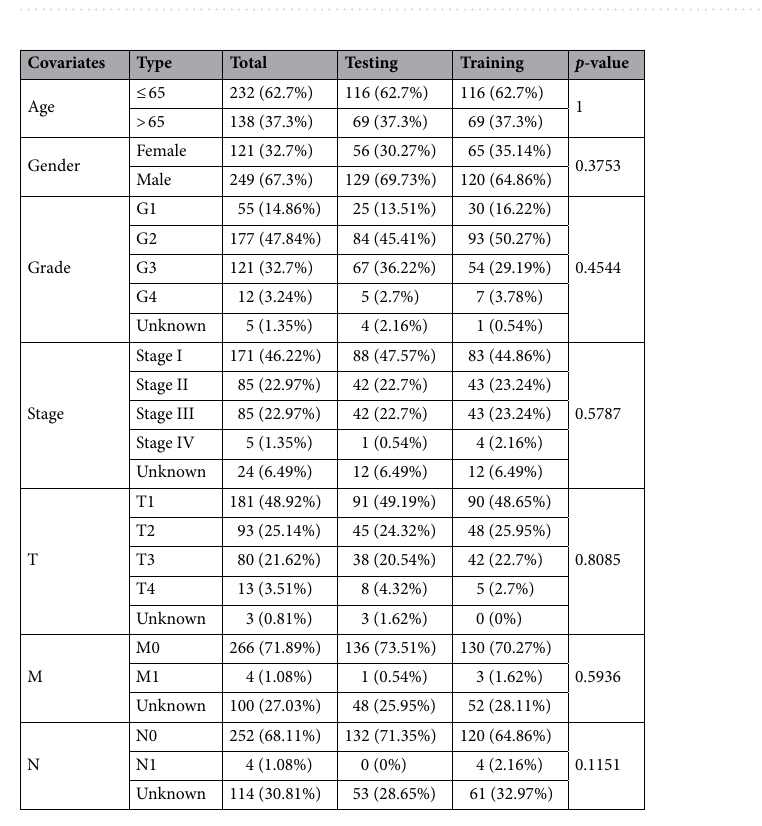
Figure 1. Identification of cuproptosis-related ICGs in HCC. ( A ) The expression heatmap of 13 cuproptosis ‐ related genes. ( B ) The co-expression network between cuproptosis-related genes and ICGs.